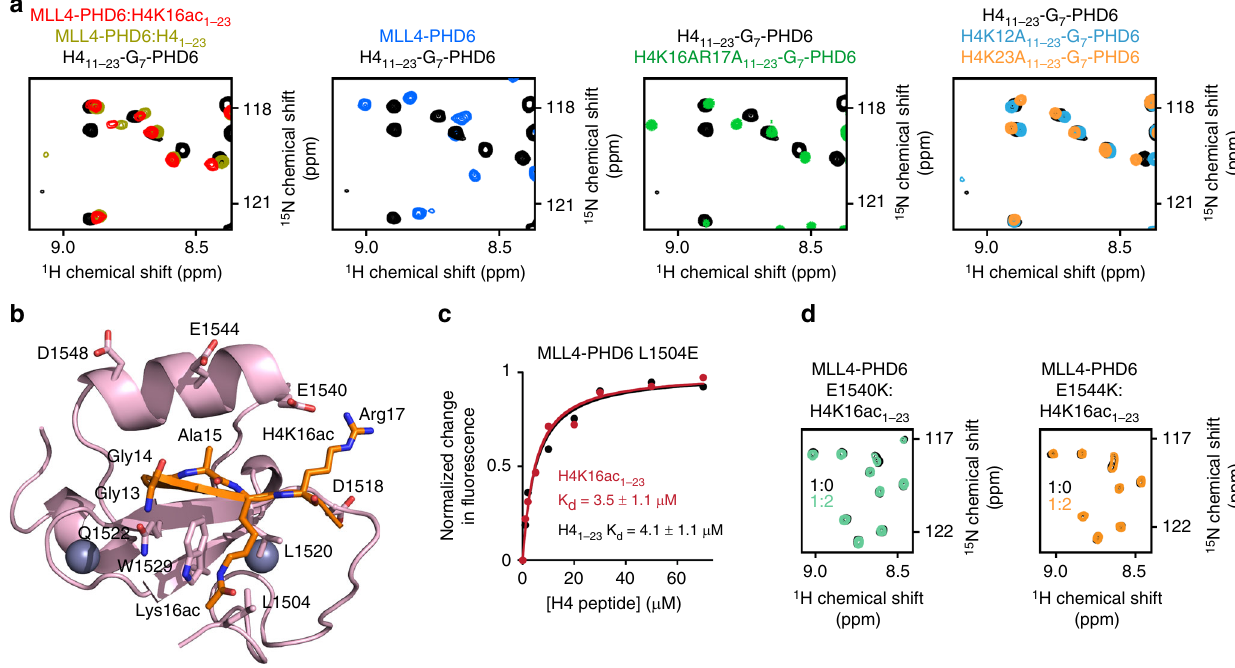
Fig. 3 Molecular basis for the speci fi c targeting of H4K16ac by MLL4-PHD6. a Superimposed 1 H, 15 N heteronuclear single quantum coherence (HSQC) spectra of the linked H4 11 – 23 -G 7 -PHD6 construct, wild-type (black) and indicated mutants (green, light blue, and orange), the isolated MLL4-PHD6 domain (blue), isolated H4-bound MLL4-PHD6 (dark yellow), and isolated H4K16ac-bound MLL4-PHD6 (red). b The structure of the H4K16ac-bound MLL4- PHD6 fi nger. c Representative binding curves used to determine the K d values for the L1504E mutant by fl uorescence spectroscopy (also see Supplementary Fig. 5). Source data are provided as a Source Data fi le. d Superimposed 1 H, 15 N HSQC spectra of MLL4-PHD6 mutants collected upon titration with H4K16ac peptide. Spectra are color coded according to the protein:peptide molar